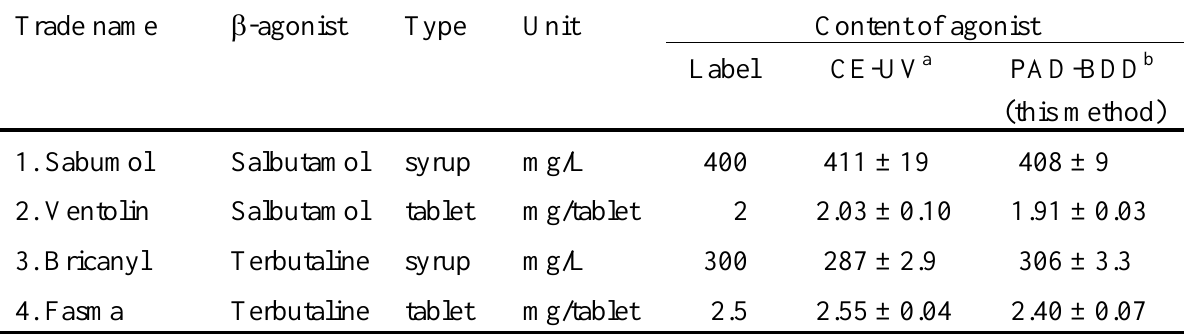
Table 3. Comparison between the determined and the labeled values of β -agonists in asthma